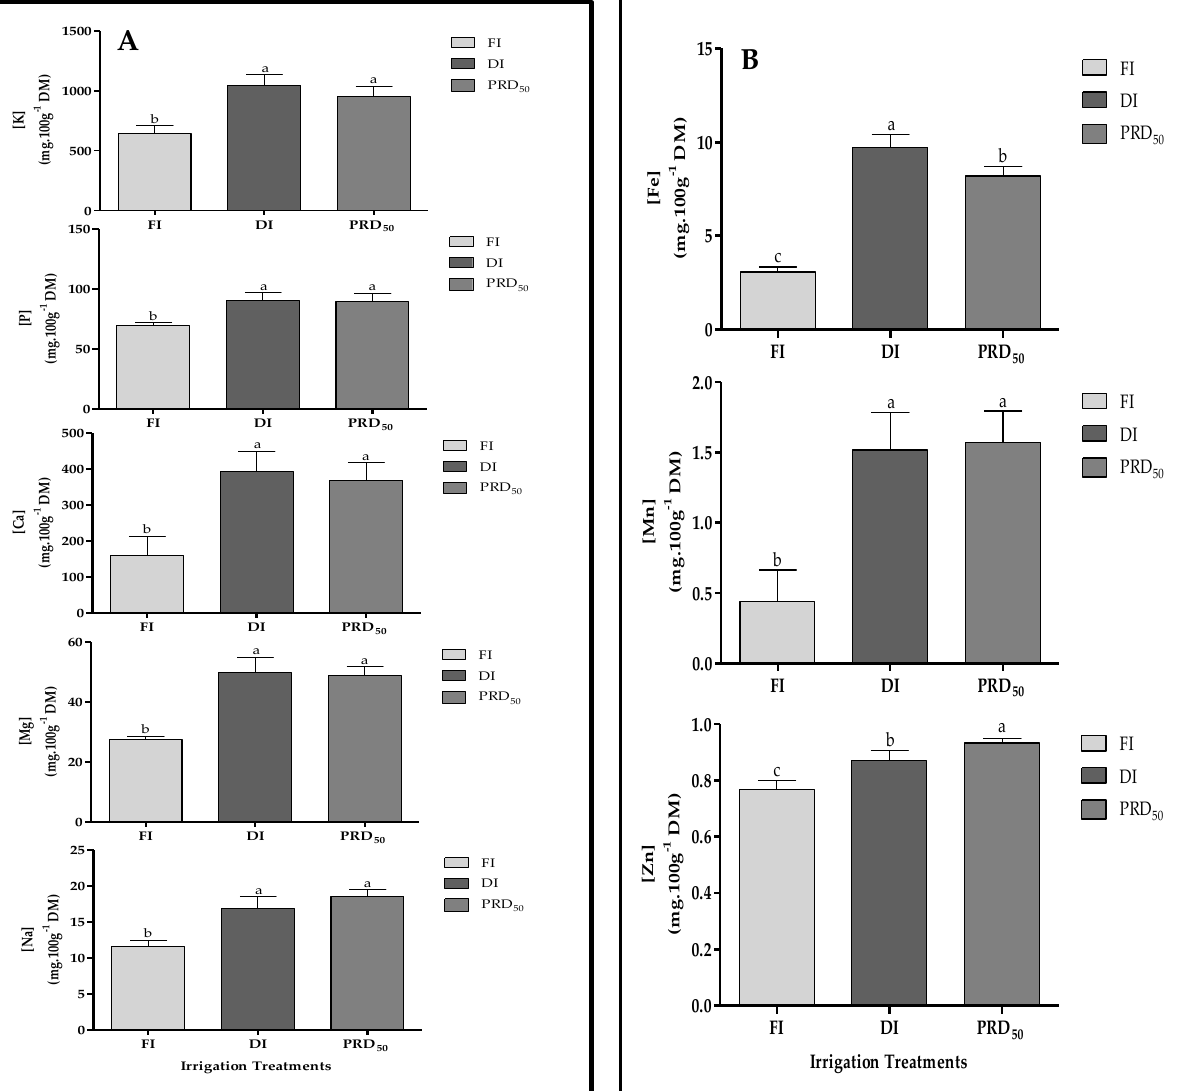
Figure 7. Macronutrient ( A ) and micronutrient ( B ) content in Flordastar peaches grown under FI, DI and PRD50 irrigation treatments, expressed in mg 100 g − 1 DM. Data are means ± SD. Different letters refer to significant differences tested by Duncan’s multiple range test ( p <